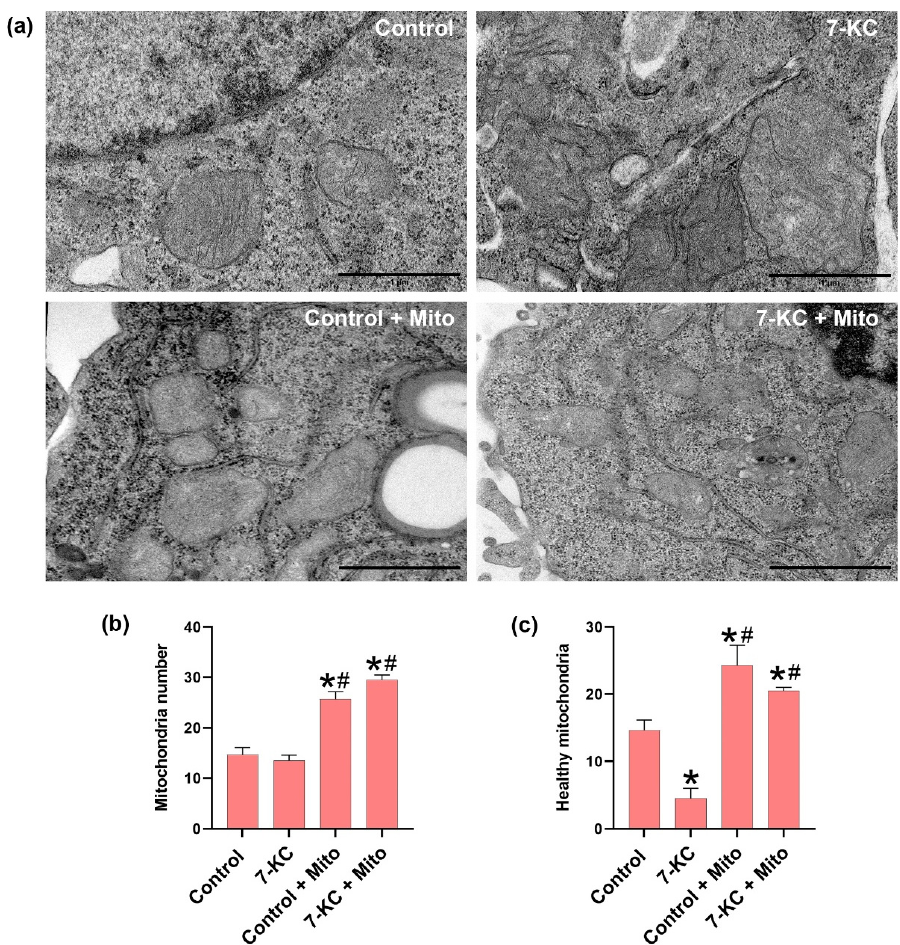
Figure 2. Electron microscopy analyses of control 7-ketocholesterol-loaded macrophages with (7-KC + Mito) or without (7-KC) mitochondrial transplantation. ( a ) Representative images acquired with a Gatan Orius digital camera by moving randomly across the EM grid and are representative of three replicates per group. ( b ) Mitochondrial number quantified from images of ultrathin sections and analyzed using ImageJ software. ( c ) Number of healthy mitochondria quantified from images of ultrathin sections and analyzed using Image J software. Data are presented as means ± SEM, n = 3, p ≤ 0.05 * vs. control, # vs. 7-KC loaded cells.